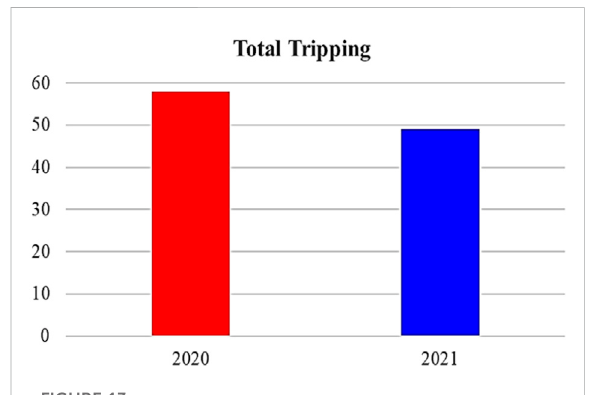
Total tripping in the transmission network in 2020 and 2021.